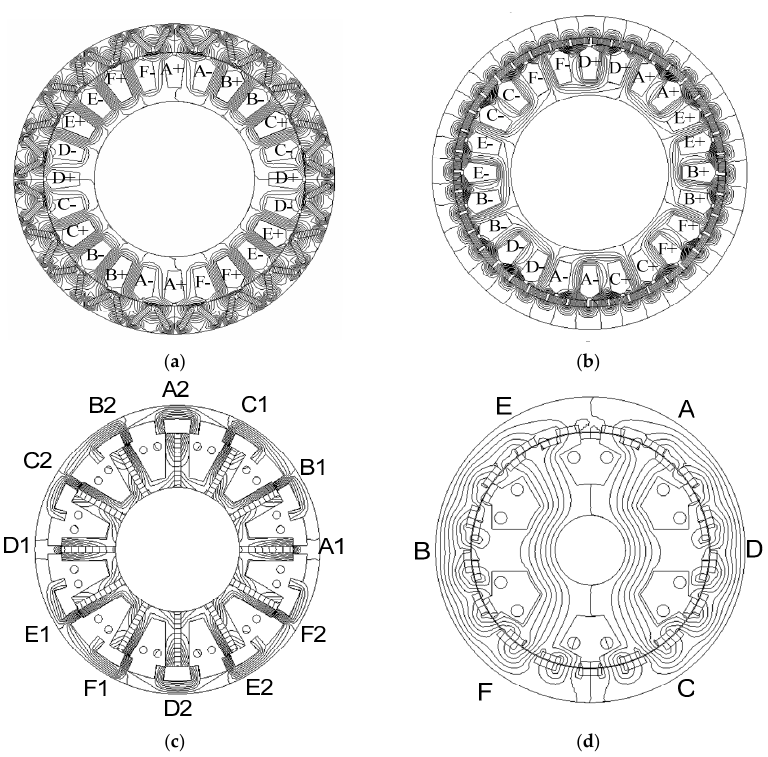
Figure 3. Magnetic flux distribution of proposed six-phase outer-rotor PM machines: ( a ) IPM type; ( b ) SPM type; ( c ) PMFS type; ( d ) PMV type. Second, the no-load EMF is governed by [28]: